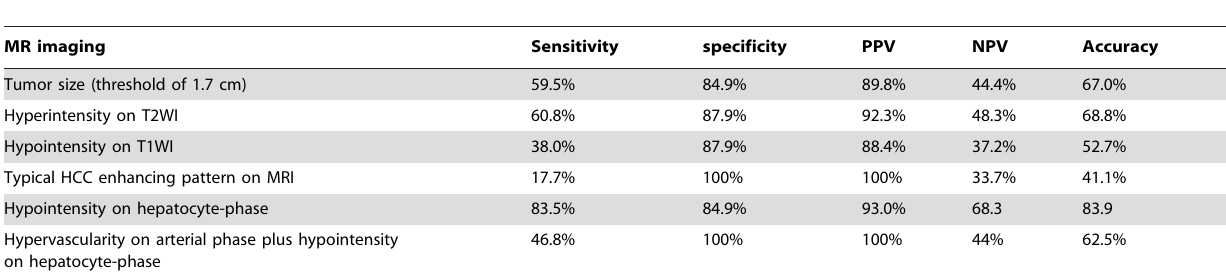
Table 4. The diagnostic performance of gadoxetic acid-enhanced MR imaging to differentiate between hepatocellular carcinoma (HCC) and dysplastic